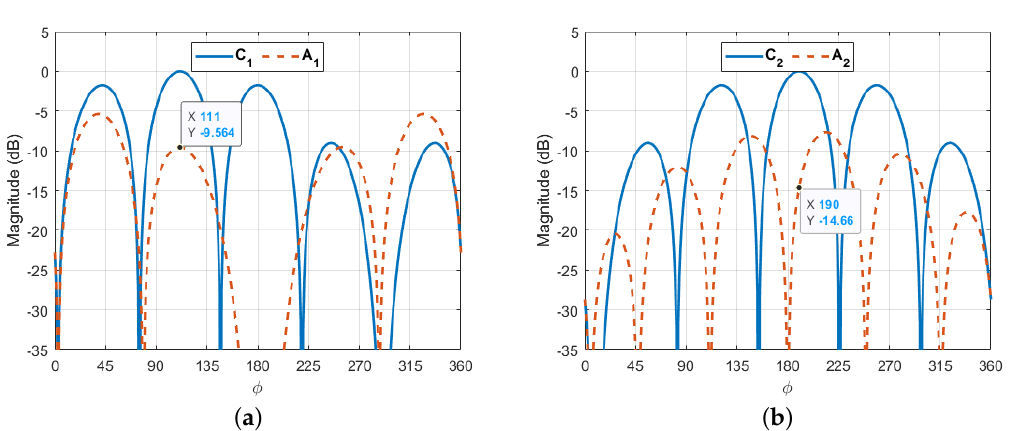
Figure 8. BER for QPSK modulation and Gray coding as a function of SNR.